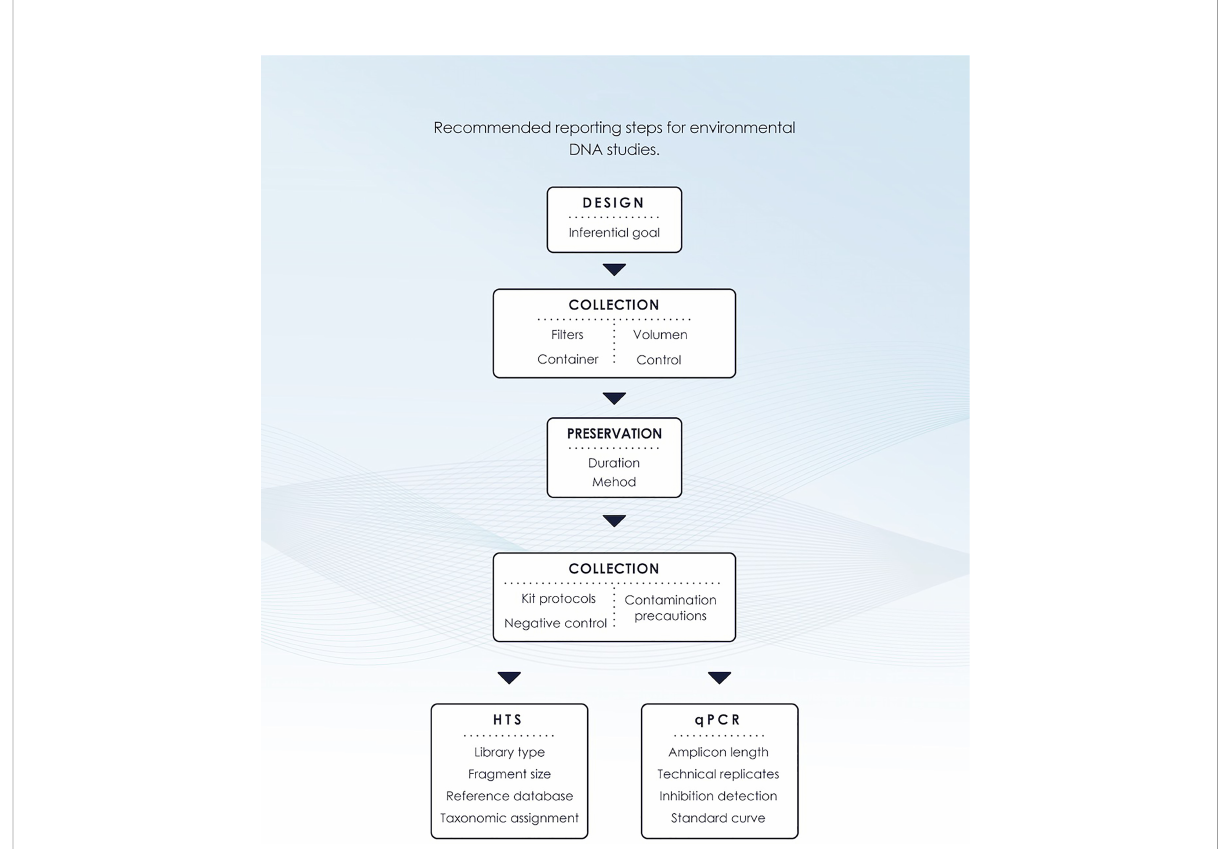
FIGURE 4 Schematic work fl ow designed for environmental DNA studies. In general, eDNA studies include the following steps: experimental design, collection, preservation, extraction, and analyses that include High-Throughput Sequencing (HTS) and/or quantitative PCR